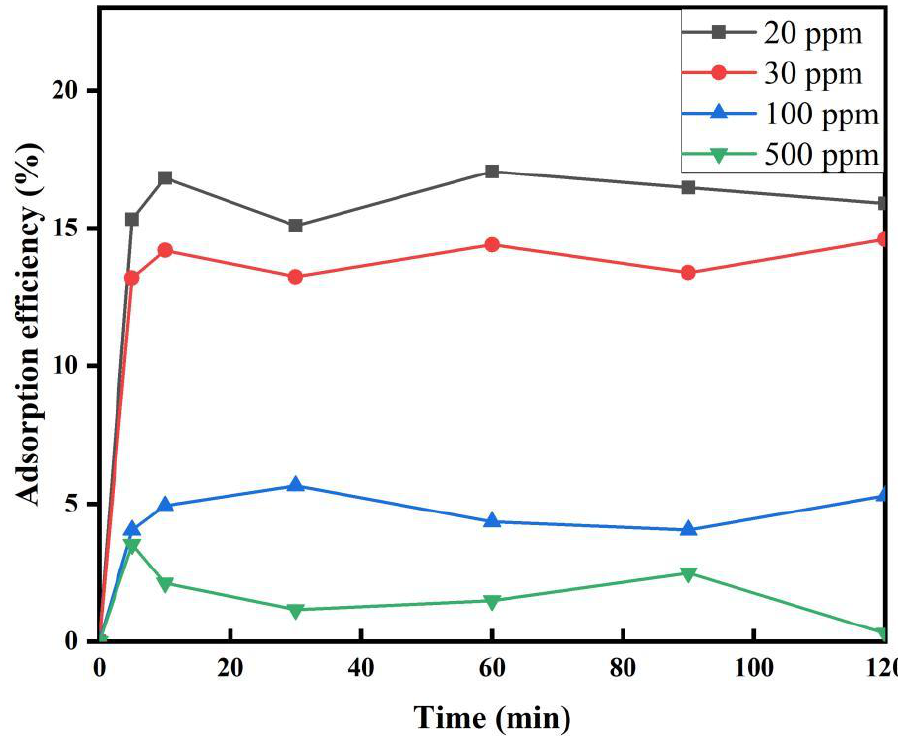
Figure 4. Effect of strontium nitrate concentration on the sorption of Sr on soil colloids. T = 25 ± 1 ◦ C, soil-liquid rate = 800 mg · L − 1 , pH = 6 ± 0.1. Table 2. Parameters for the Langmuir and Freundlich isotherm models at different initial concentrations. Langmuir